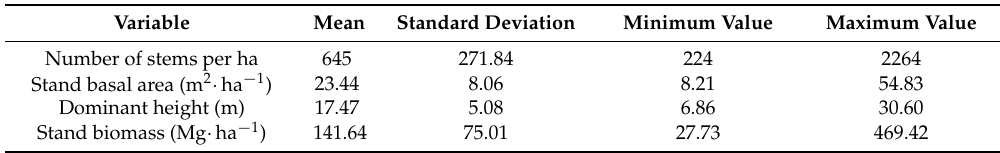
Table 1. Descriptive statistics of the total aboveground biomass per hectare in the 201 permanent forest growth and soil monitoring plots